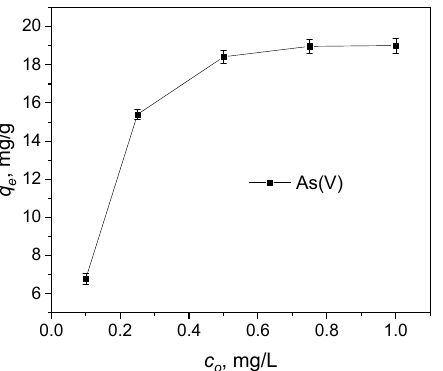
Figure 4. Effect of initial As(V) concentration on metal uptake by impregnated resin (for pH = 6).